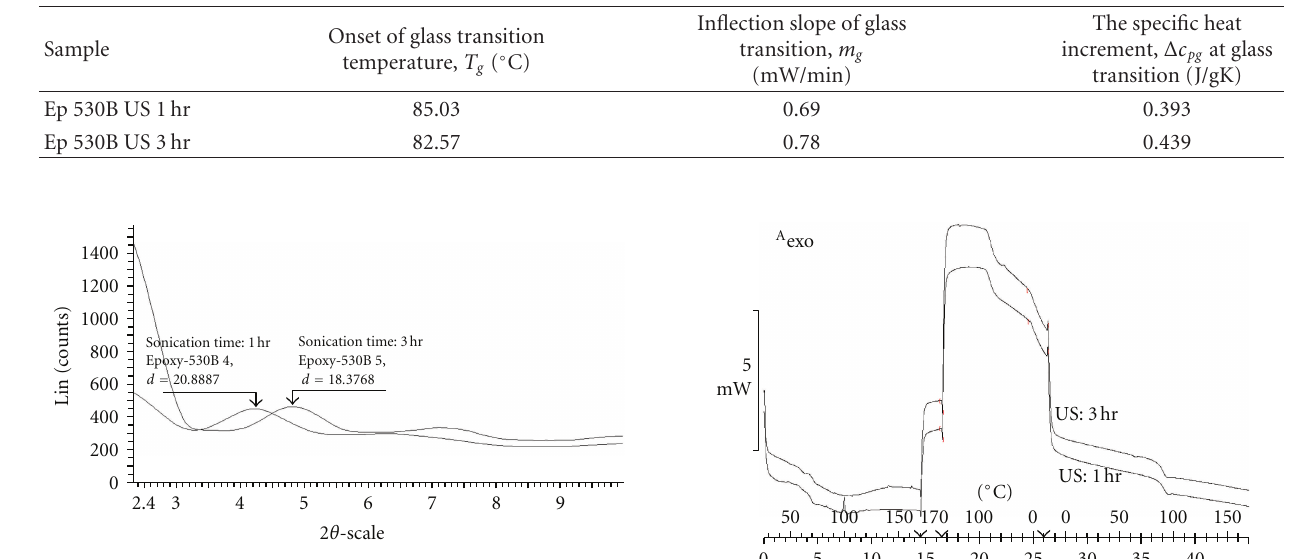
Figure 2: XRD spectra of sample prepared with (a) 1 hour and (b) 3-hour sonication treatment.